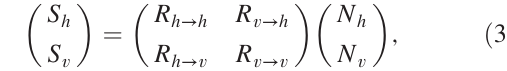
TABLE III. TCT response matrices R estimated with FLUKA for the 2011 physics run for B1 (3.5 TeV, β (cid:2) ¼ 1 . 5 m). The response is defined as the BLM signal per lost proton on the TCT, normalized by the response at the TCP. The total BLM signal is the sum of the contributions from both TCTs as shown in Eq. (3). It should be noted that the presented values are likely to change if the optics, beam energy, or collimator settings are modified.